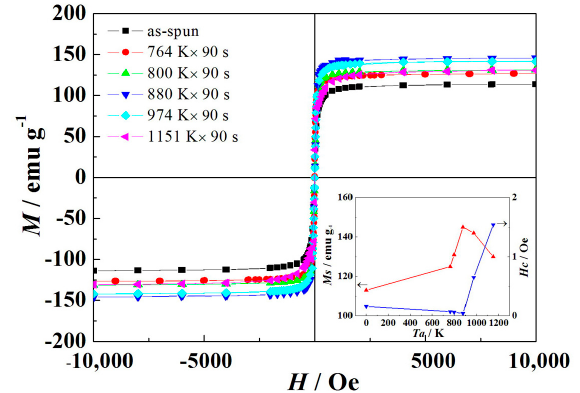
Figure 8. Room-temperature magnetization hysteresis curves for the (Fe 0.4 Co 0.6 ) 79 Nb 3 B 18 alloys annealed at different temperatures.